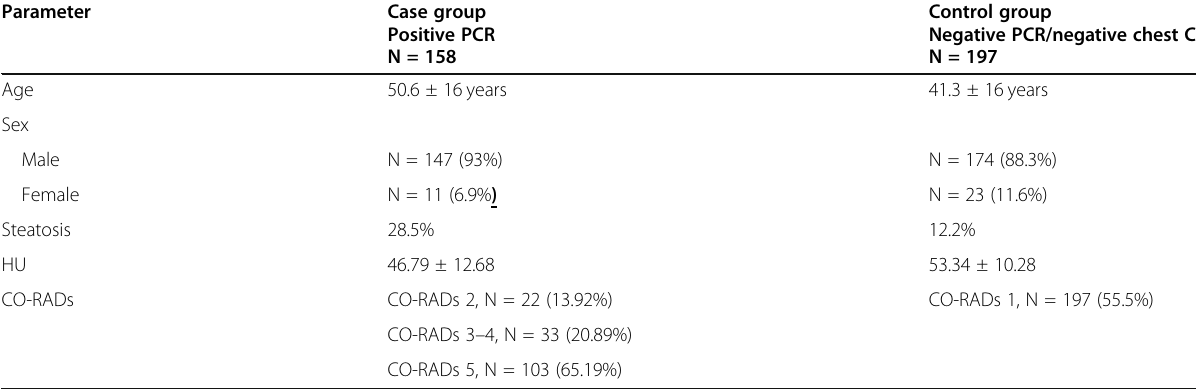
Table 1 Demographic comparison parameters and statistics between the two groups